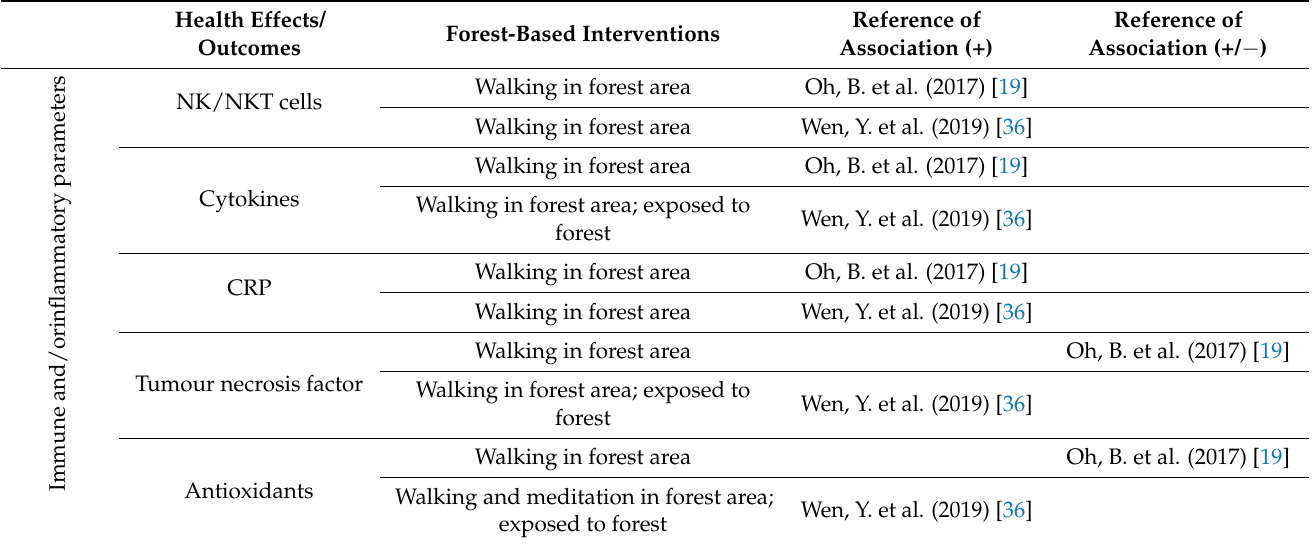
Table 4. Summary of associations between forest-based interventions and health effects/outcomes in immune and inflam- matory parameters.